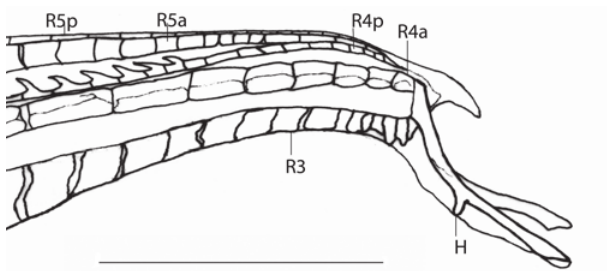
Fig. 20. Gonopodium tip of Phalloceros aspilos , MCP 30509. R3, R4a, R4p, R5a, R5p indicate gonopodial rays. Scale bar 1 mm.